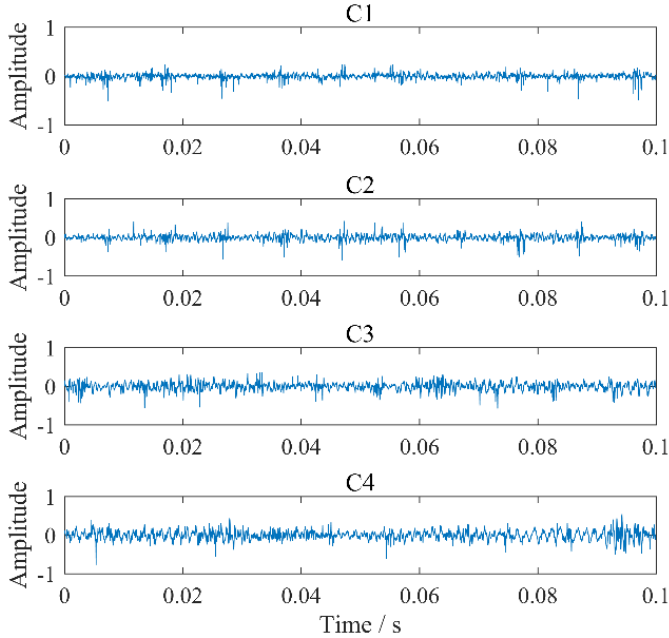
Figure 12. The waveform of cutting vibration signal.